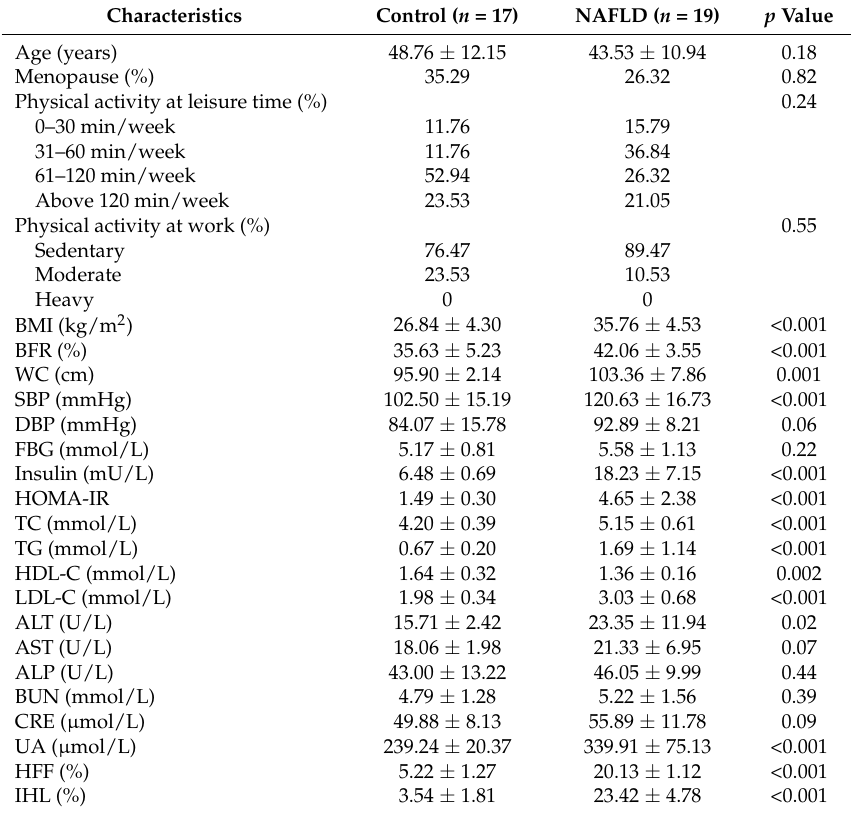
Table 1. Characteristics and anthropometric and clinical variables of